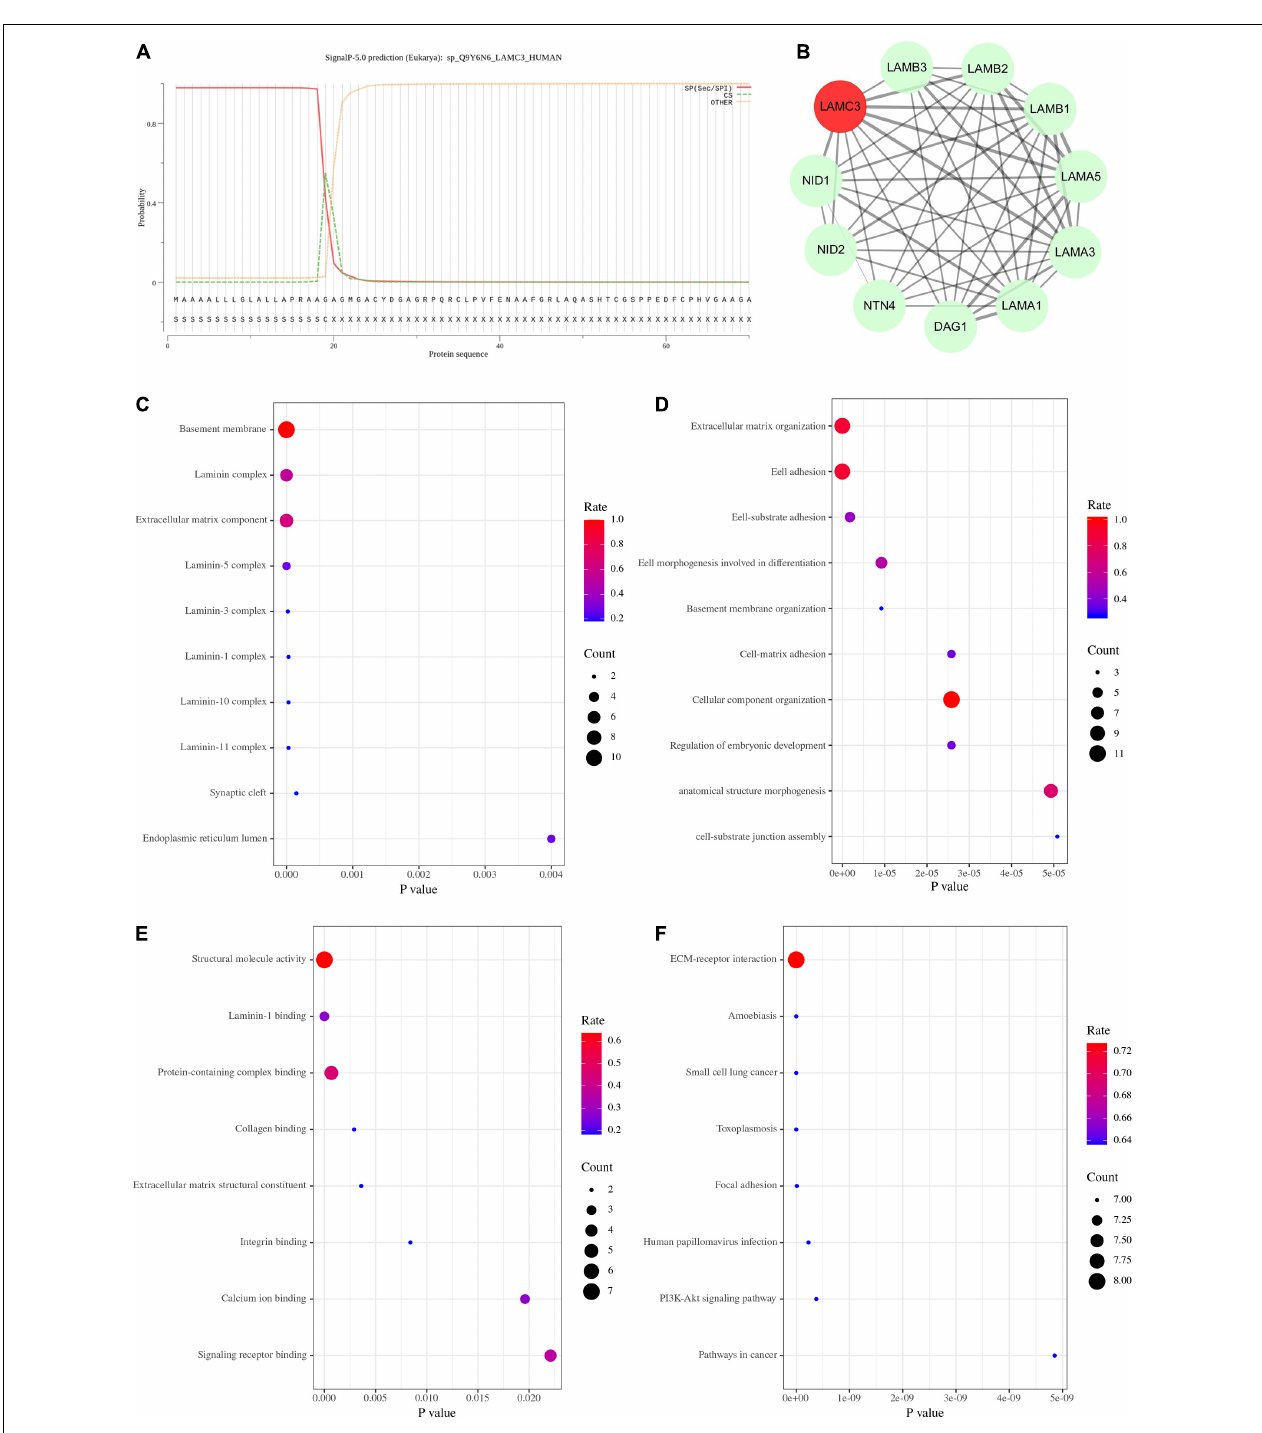
FIGURE 3 | The bioinformatics analysis of LAMC3 gene. (A) The first 19 amino acids of the laminin γ 3 chain were predicted as a signal peptide. (B) The protein-protein interaction network showed 10 genes ( DAG1 , LAMA1 , LAMA3 , LAMA5 , LAMB1 , LAMB2 , LAMB3 , NID1 , NID2 , and NTN4 ) that have potential interactions with LAMC3. (C) The cellular component of gene ontology showed LAMC3 and its interacting genes were mainly located in the basement membrane, extracellular matrix organization, laminin complex. (D) The biological process of gene ontology indicated these genes were mainly associated with extracellular matrix organization, cell adhesion, cellular component organization, and anatomical structure morphogenesis. (E) The molecular function of these genes were primarily involved in structural molecule activity, protein-containing complex binding, signaling receptor binding, and laminin-1 binding. (F) The KEGG pathway enrichment analysis showed eight potential signal pathways of these genes, including ECM-receptor interaction, amoebiasis, small cell lung cancer, toxoplasmosis, focal adhesion, human papillomavirus infection, PI3K-Akt signaling pathway, and pathways in cancer.